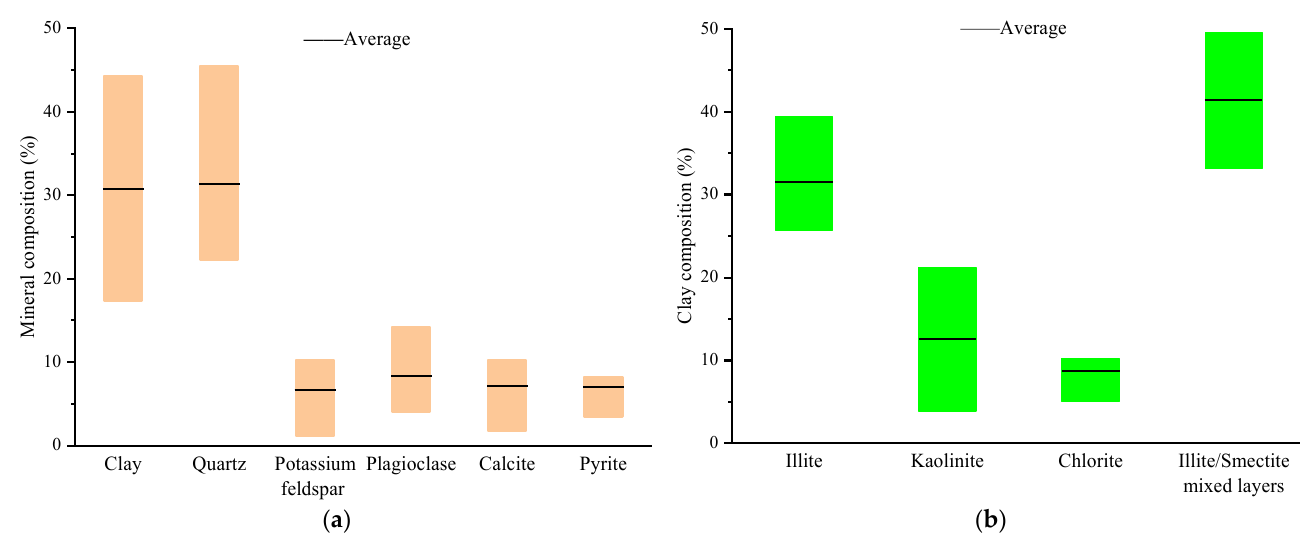
Figure 1. Mineral content of the third submember of the Chang 7 member: ( a ) Mineral content fluctuation diagram; ( b ) clay content fluctuation diagram.